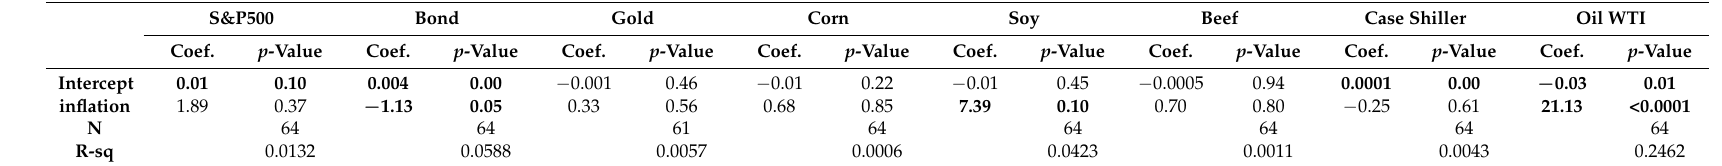
Table 6. Regression results table: indexes, September 2011 to December 2016.